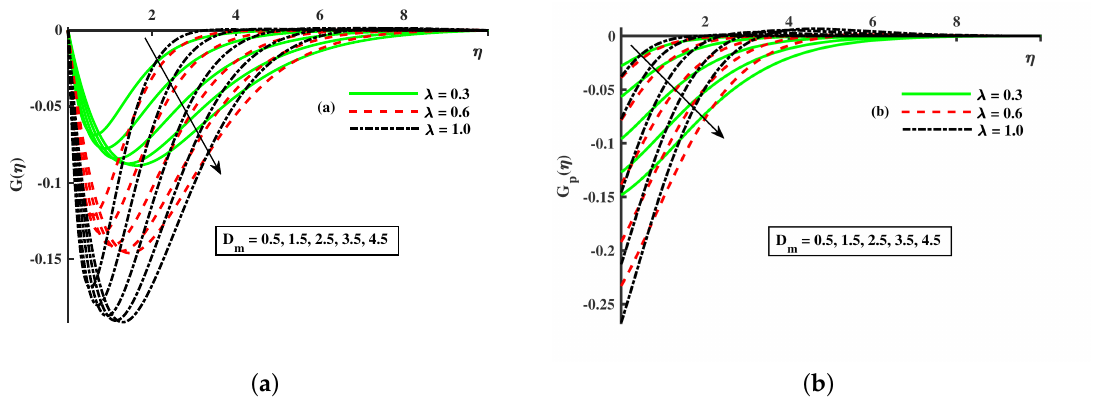
Figure 6. Fluctuation of λ and D m on G ( η ) ( a ) and the effect of λ and D m on G p ( η ) ( b ).